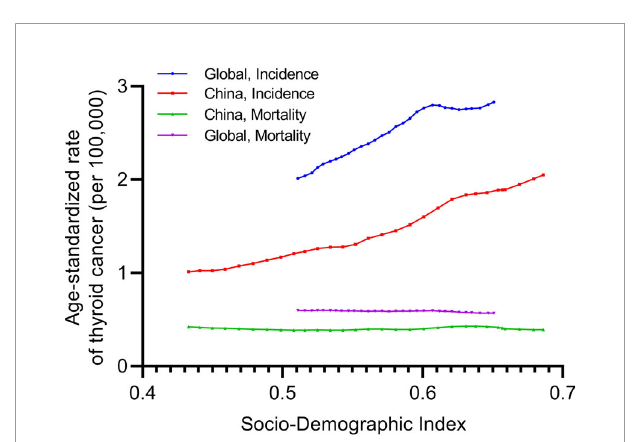
FIGURE 3 | Age-standardized incidence and mortality rates of thyroid cancer globally and in China by sociodemographic index, 1990 –